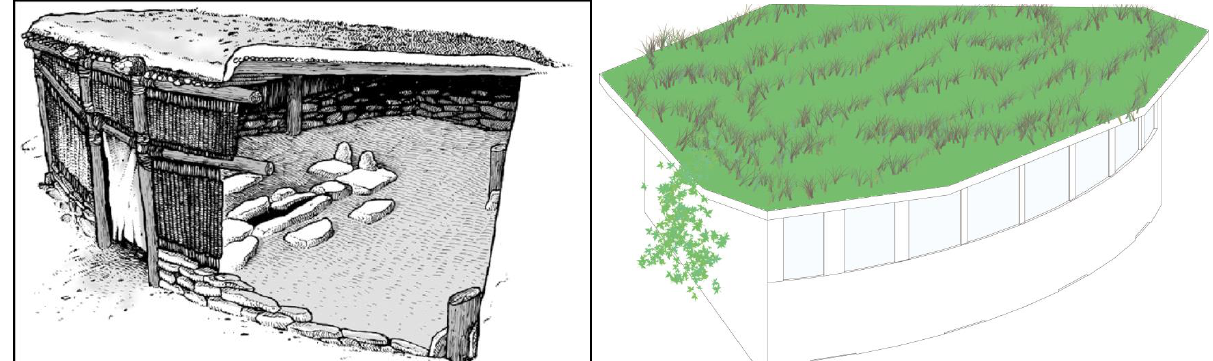
Figure 37. In direct comparison to possible reconstruction of prehistoric dweling, the simplified axonometric of a tourist unit shows how easy it is to perform. There are only vertical walls. In relation to the Neolithic Lepenski Vir house, noticeable changes are flat roofs and windows on the semi-circular wall. But these are more adjustments to our time and needs than essential changes. Our new technologies, with modern materials and machines, enable us this long row of connected windows. Flatt roof was mentioned by Le Corbusier in his five points on architecture. In this case, it can be covered with soil, grass, and flowers. Let us return nature to the little earth that we have taken, treat and use nature for our basic needs, and not to hurt it. Let us build with nature, not against her, because she is here longer than us and will be here long after us. Therefore, to fight it, it is useless. The centre of events in the former Lepenski Vir had direct coastline, harbour, and water. For the location in this project to be connected with the Danube River tours, within the settlement there would be a small port with a marina, in a natural bay on the site. The building is of the same shape as the old objects of Lepenski Vir, but for the needs of tourists, compared to the previous one, it is luxurious. There is a narrow entrance part, and opposite to it there is all the remaining area, which is used as a sleeping room, and as a living room, dining room and kitchen. The bathroom is located next to the entrance, for the more rational use of the total area. One of the biggest problems was that the sun is sometimes too strong. During the analysis, people who rented such spaces have made it clear that they do not want to jeopardize their privacy, and therefore the windows have remained at a height where no one can look inside in another object. The windows thus serve only to pass the